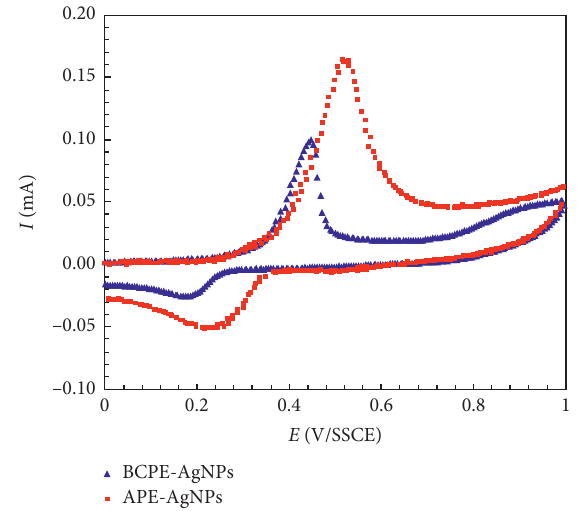
Figure 8: Cyclic voltammograms of BCPE-AgNPs and APE- AgNPs at a scan rate of 100mVs − 1 in acetate buffer 0.1 M (pH 4) and NaClO 4 (70:28: 2).